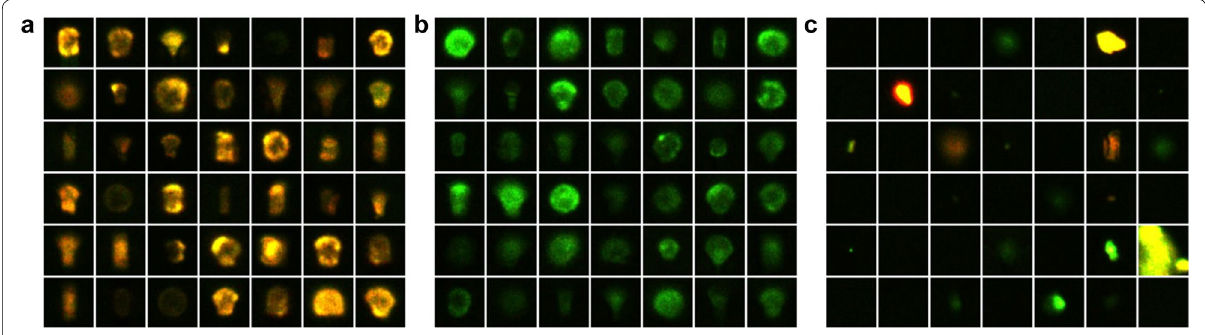
Fig. 3 Dataset after automated labeling of cells. a B-cells, b T-cells and c background